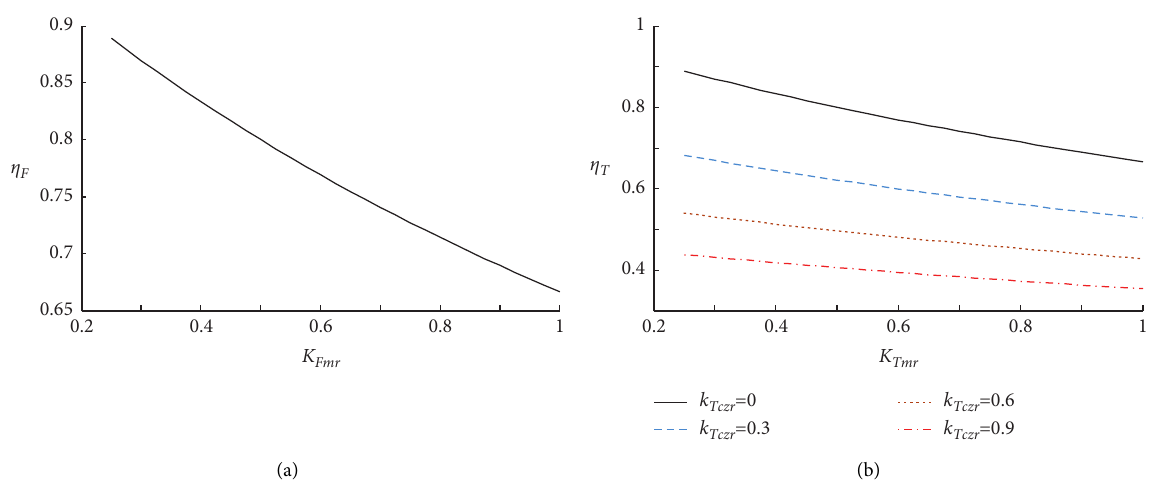
Figure 7: The drill flange/screw interface impact stress transmission efficiency. (a) Transmission efficiency of the flange interface. (b) Transmission efficiency of the screw interface.